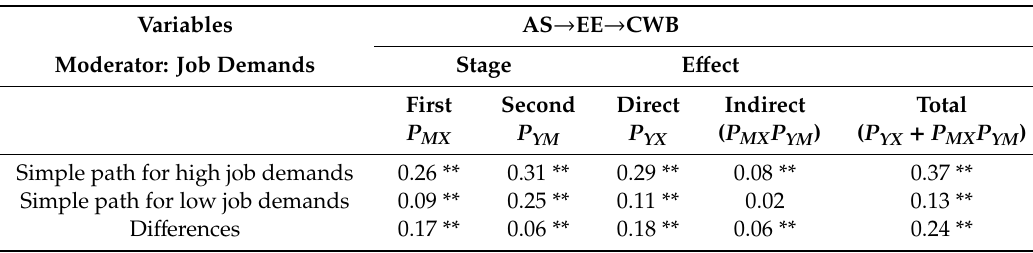
Table 4. The results of moderated path